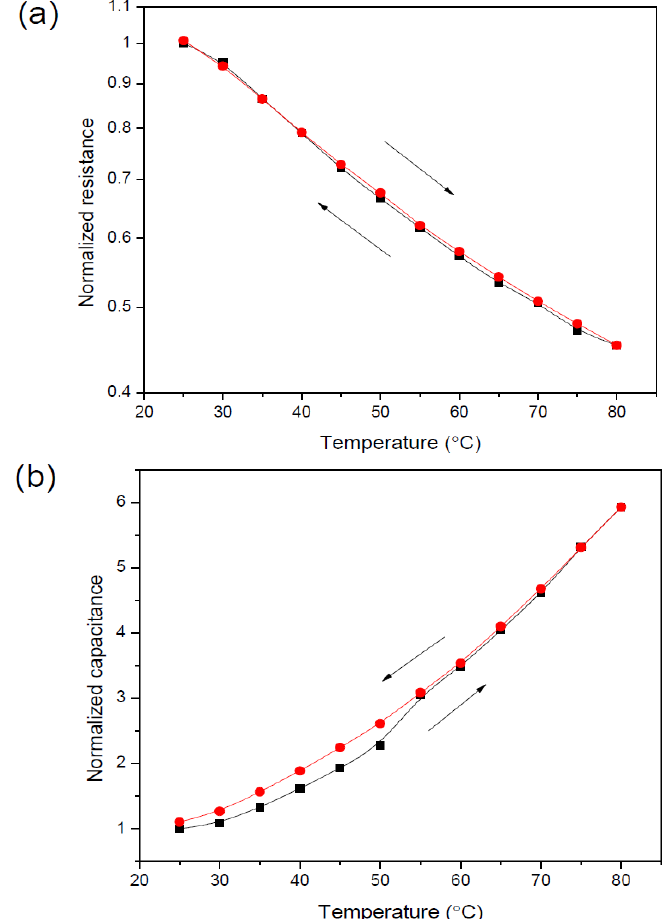
Figure 6. Hysteresis plot of the normalized resistance ( a ) and capacitance ( b ) towards temperature variation of the